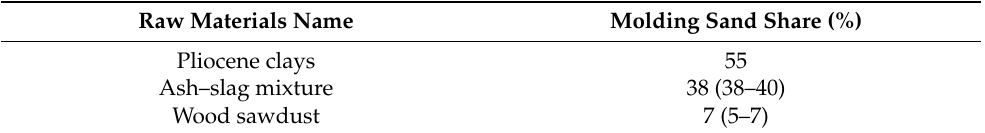
Table 4. The composition of the molding sand used for the production of tested ceramic building materials (clay masonry units).